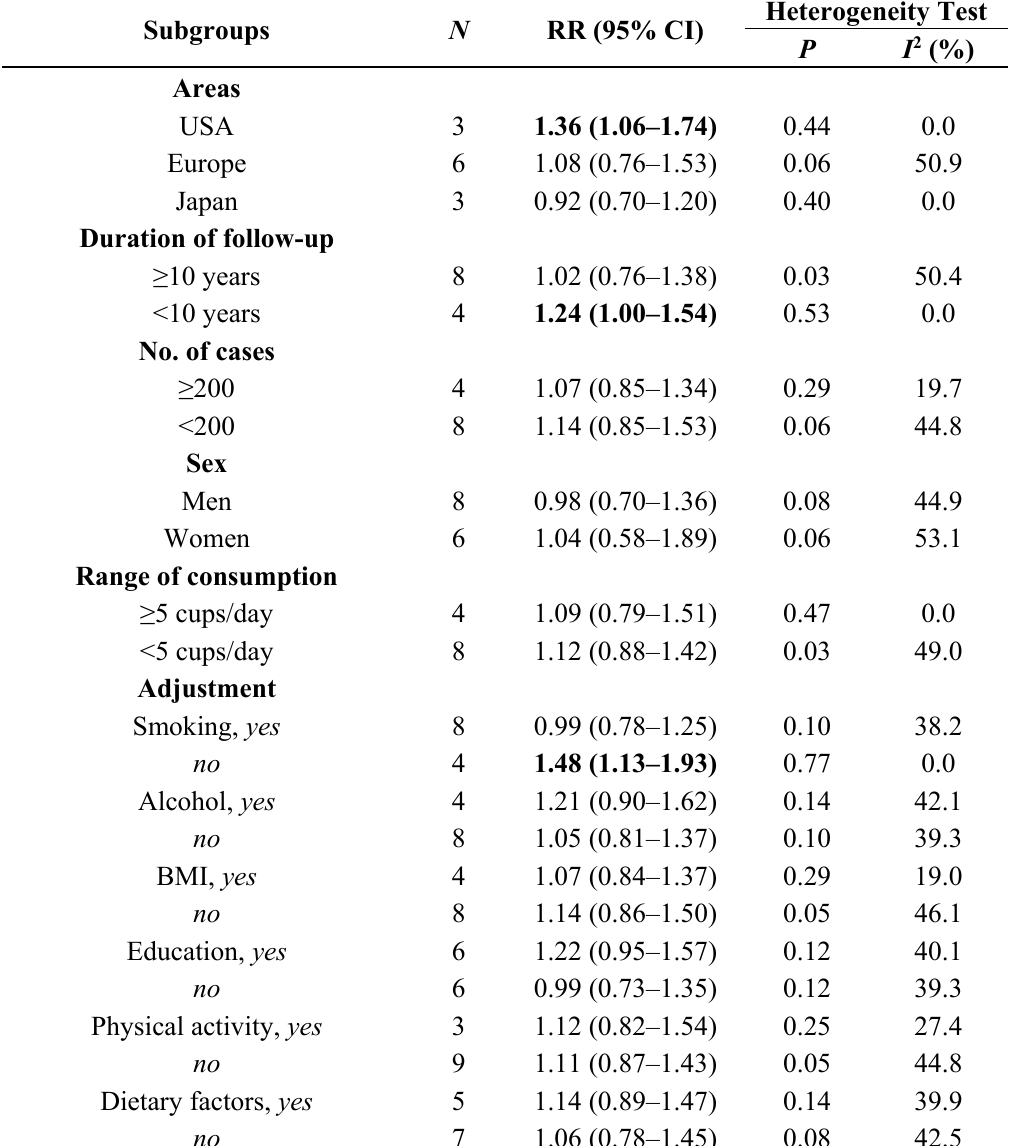
Table 2. Subgroup analysis for the association of coffee consumption with risk of gastric